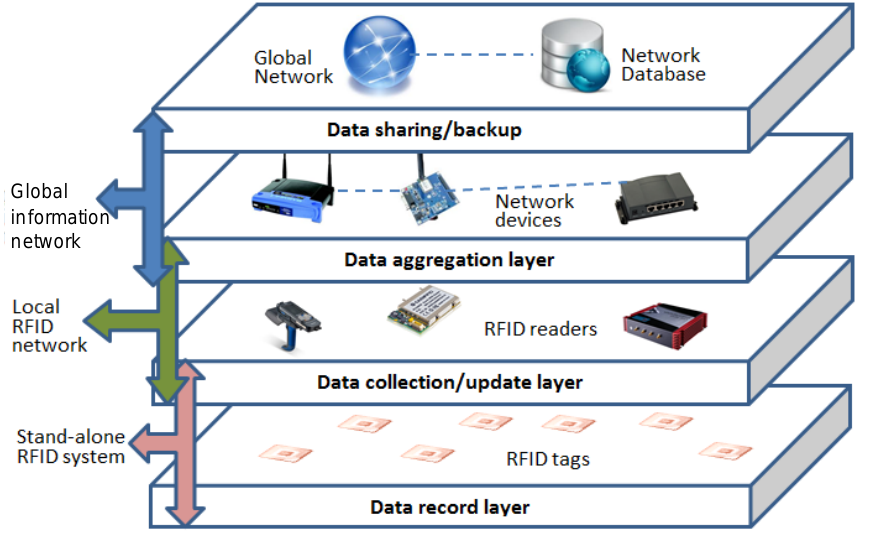
Figure 4. RFID-based carbon emission recording/tracking system